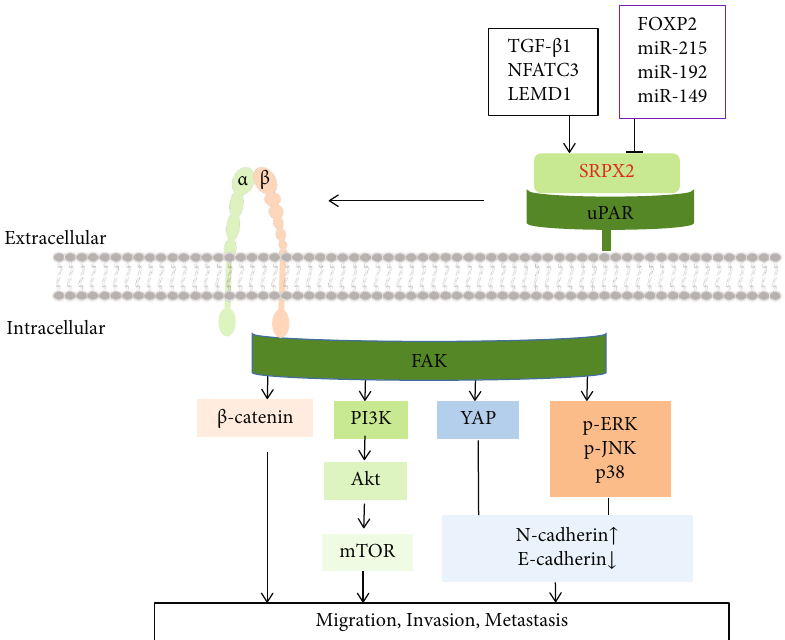
Figure 3: SRPX2 regulates cancer cell metastasis, migration, and invasion by regulating various signaling